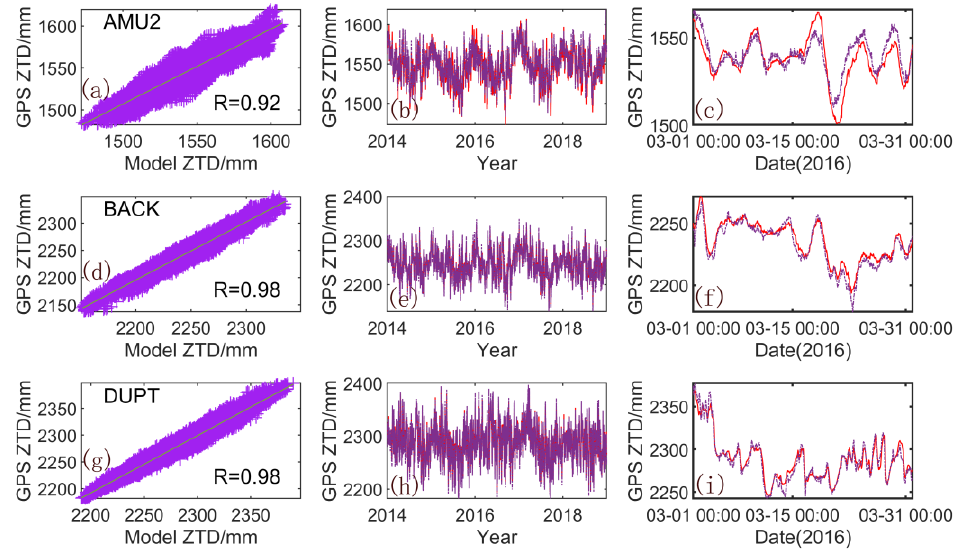
Figure 7. Comparison of GPS-ZTD and PCA-ZTD for the AMU2, BACK, and DUPT stations. ( a , d , g ) are correlation between the GPS-ZTD and PCA-ZTD; ( b , e , h ) are their time series from 2014 to 2018; ( c , f , i ) are time series in one month. Red solid line: PCA-ZTD; purple solid line: GPS-ZTD.).